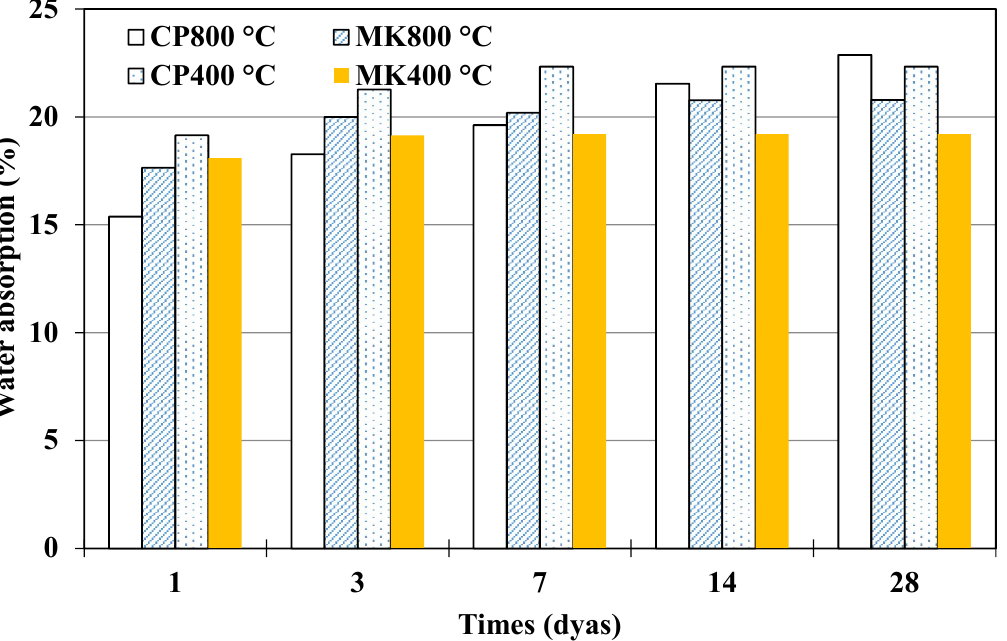
Figure 14. Water absorption of cement paste and metakaolin-cement paste after elevated temperature exposure.